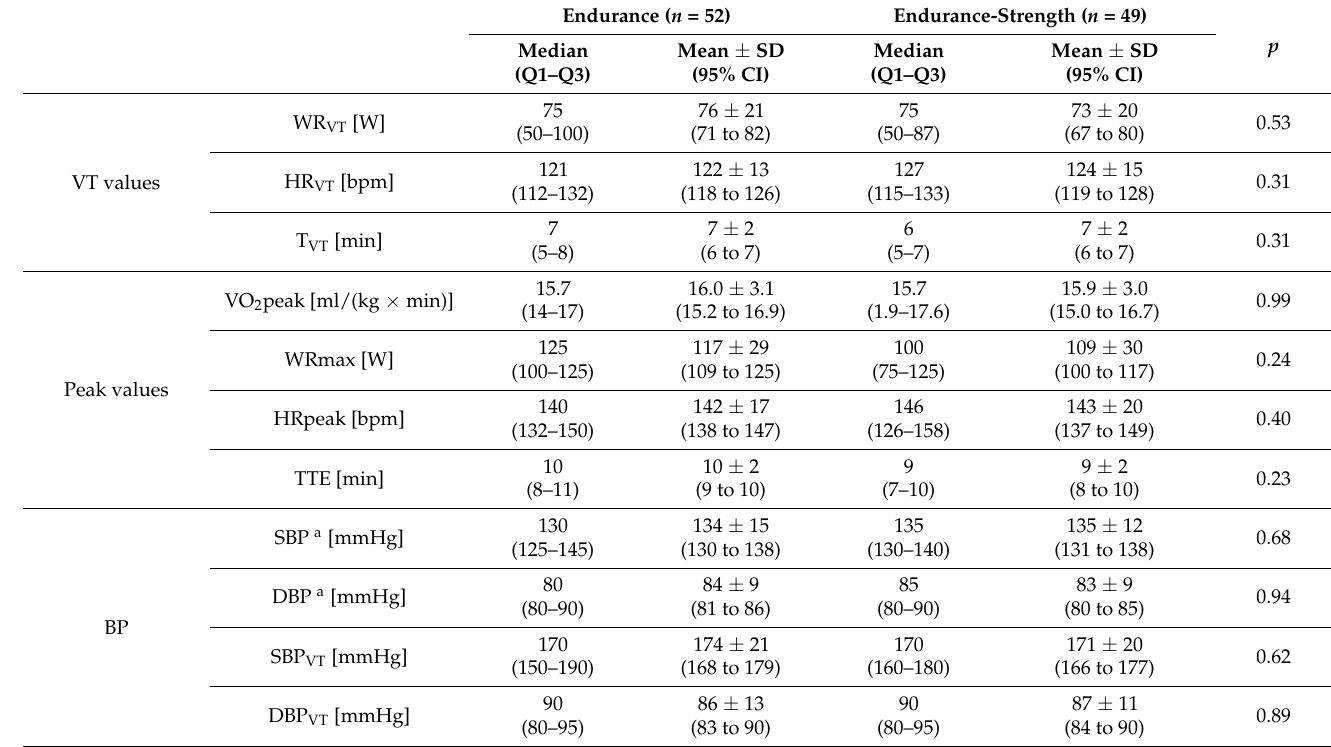
Table 2. Baseline physical capacity of the study population ( n =